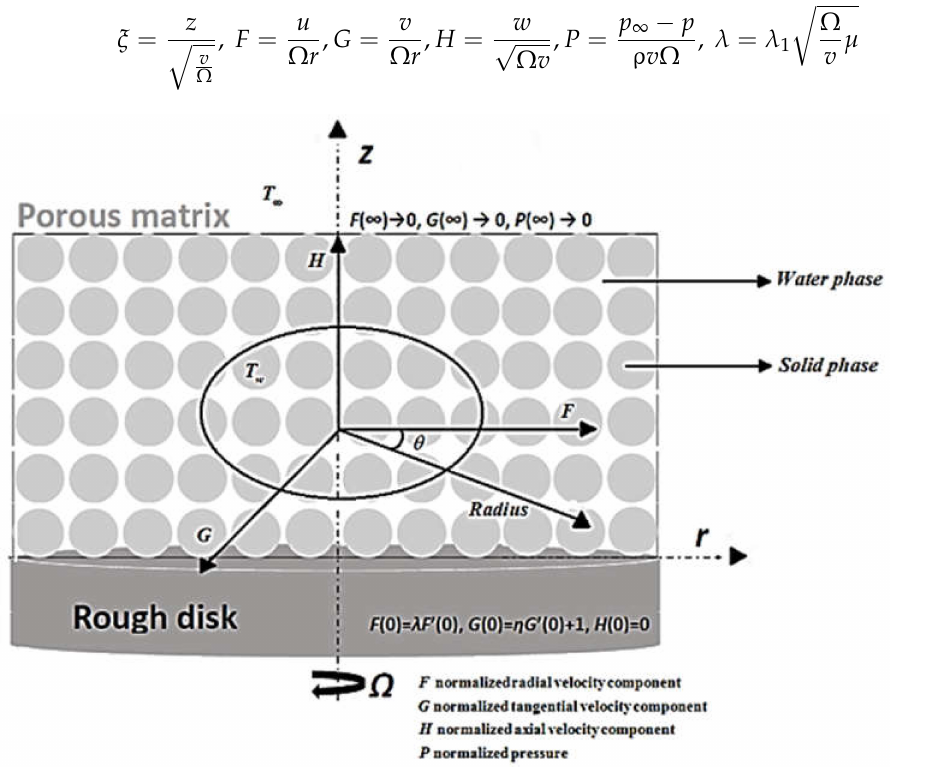
Figure 1. The coordinate system of the Von K á rm á n flow in a porous medium with its boundary